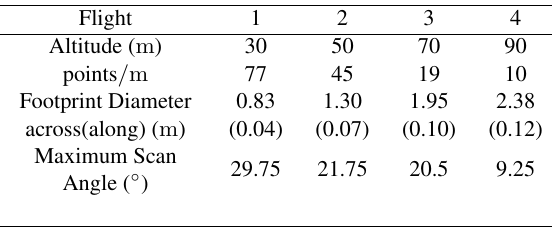
Table 1. Flight conditions over the field measured pre-pruning assessment plot.